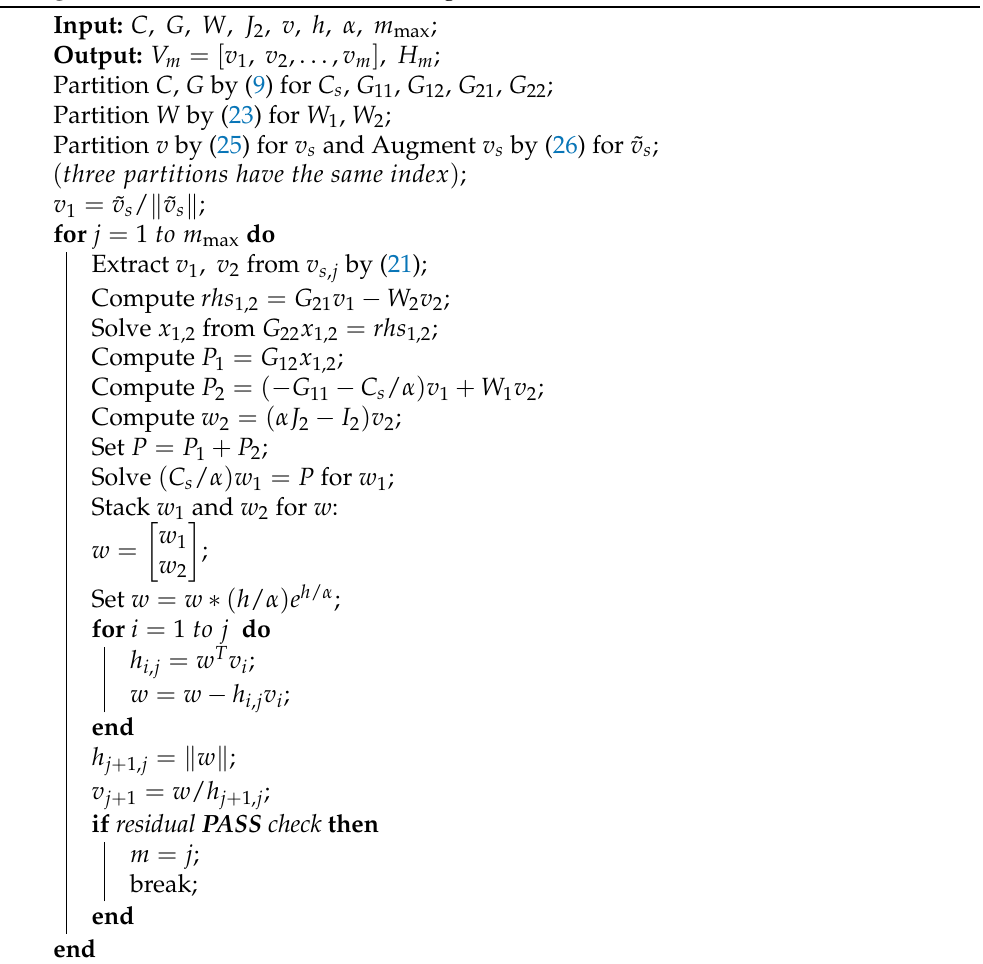
Algorithm 2: Arnoldi Process with